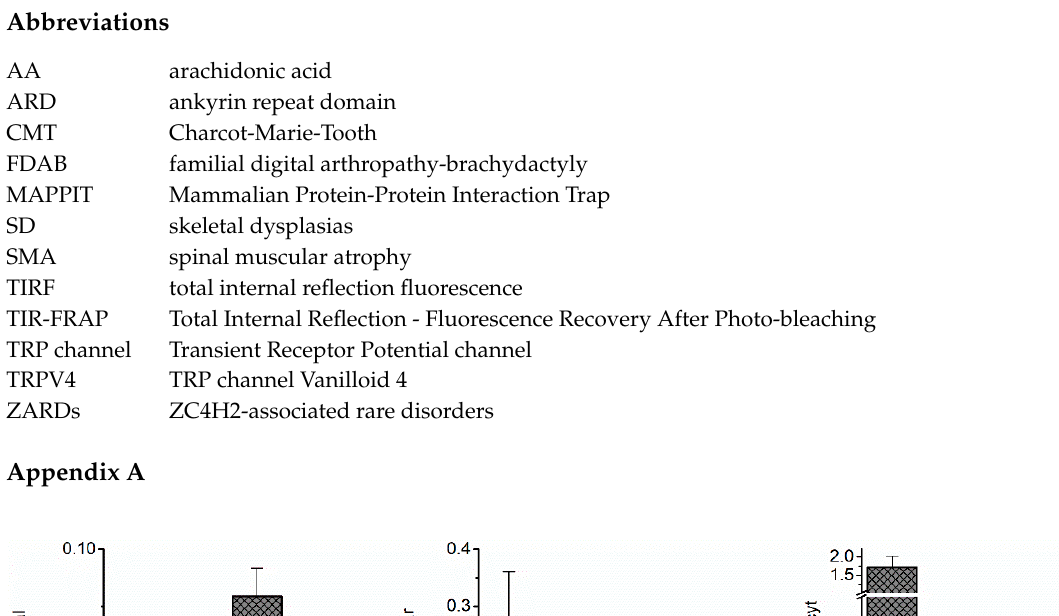
Figure A2. Expression levels of TRPV4 and ZC4H2 in HEK-293T cells. mRNA expression of TRPV4 and ZC4H2 in non-transfected (NT) cells and cells co-transfected with TRPV4-GFP and ZC4H2- mCherry.